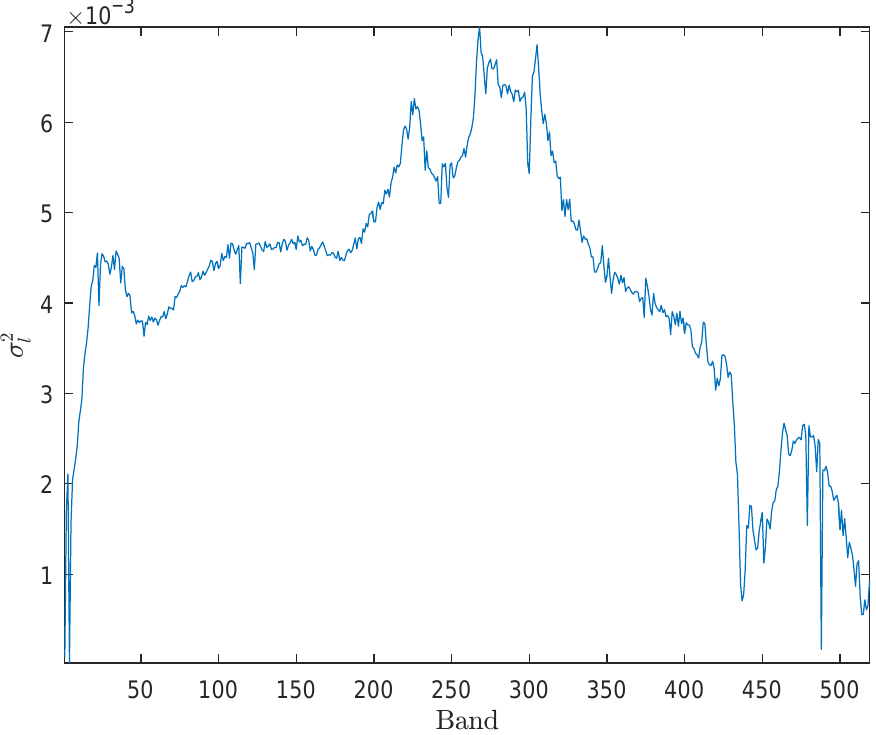
Figure 6. The calibrated noise parameters σ 2 of the employed hyperspectral camera. l Network training: When training the network, patches with a 128 × 128 spatial size were randomly cropped and augmented by random flipping or rotations. The batch size was set to 4. The Charbonnier loss [34,35] and the Adam optimizer [36] were utilized